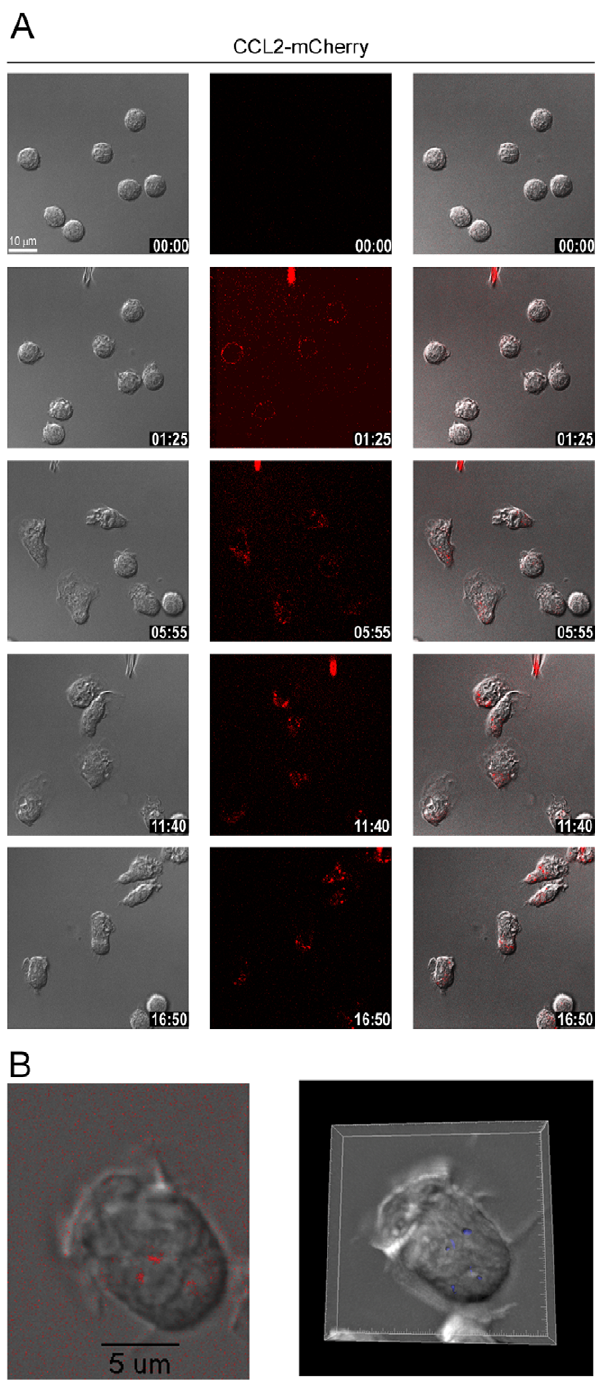
Figure 2. Monocytes internalize CCL2-mCherry during migra- tion. Selected frames from time-lapse video microscopy (Movie S1) of migrating human monocytes recorded at 37 u C (A). The micropipette was dispending 100 nM CCL2-mCherry with constant backpressure. Left panels phase images, middle panels CCL2-mCherry (ex 594 nm/em 620–680 nm), and right overlay. Time stamps are indicated in mm:ss, calibration bar 10 m m (top left panel). (B) Single cell recorded at higher magnification (100 6 ). Left plane from a confocal stack, right 3D rendering from the stack. The endosomal surface (blue) was calculated from the mCherry fluorescence using the Imaris software package (see also Movie S2).